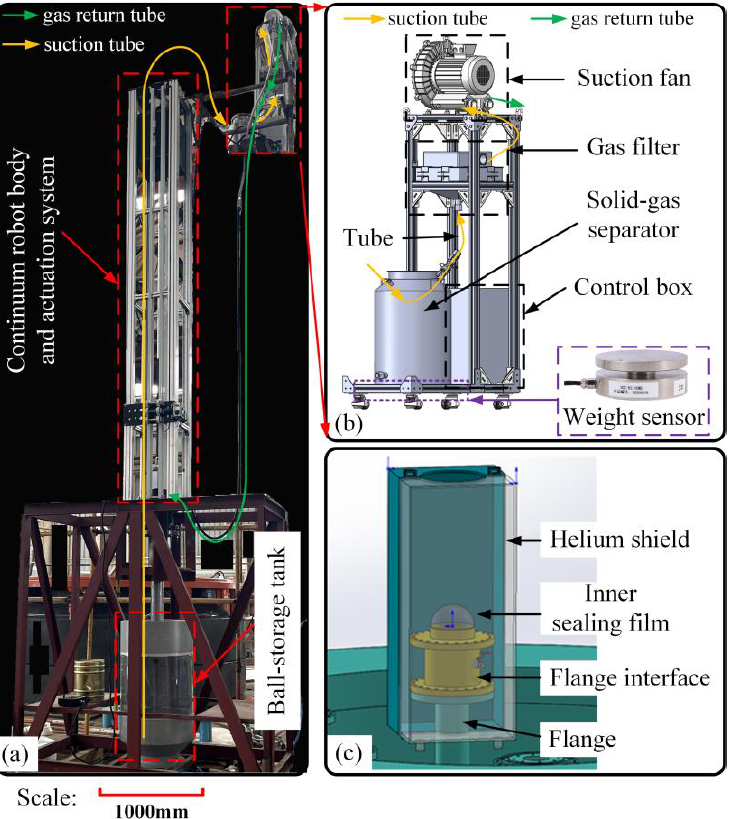
Figure 9. Test prototype of the continuum robot. The yellow arrow indicates the suction tube and the green arrow indicates the gas return tube. ( a ) Test prototype. ( b ) Negative pressure-removal and control system. ( c ) Helium protection device.